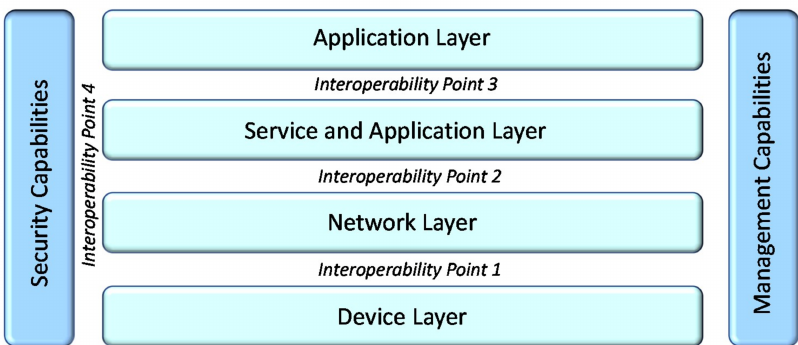
Figure 3. IoT reference model (ITU-T Y.2060) and the points where interoperability solutions can be